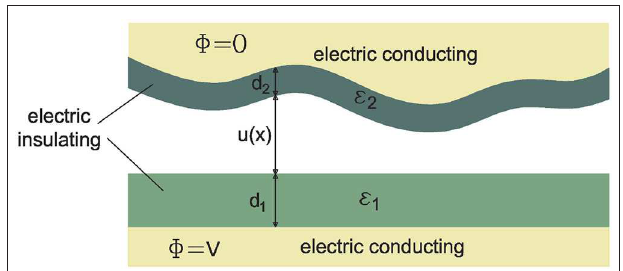
FIGURE 1 | Sketch of the geometry considered: A rough elastic solid is squeezed against a flat rigid solid. Both solids are made of conducting materials, with insulating coatings of thicknesses d 1 and d 2 and dielectric constants ε 1 and ε 2 . An electric voltage difference V is applied at the two u ( x ) depends on the in-plane coordinate solids. The interfacial separation u = x ( x , y ). =